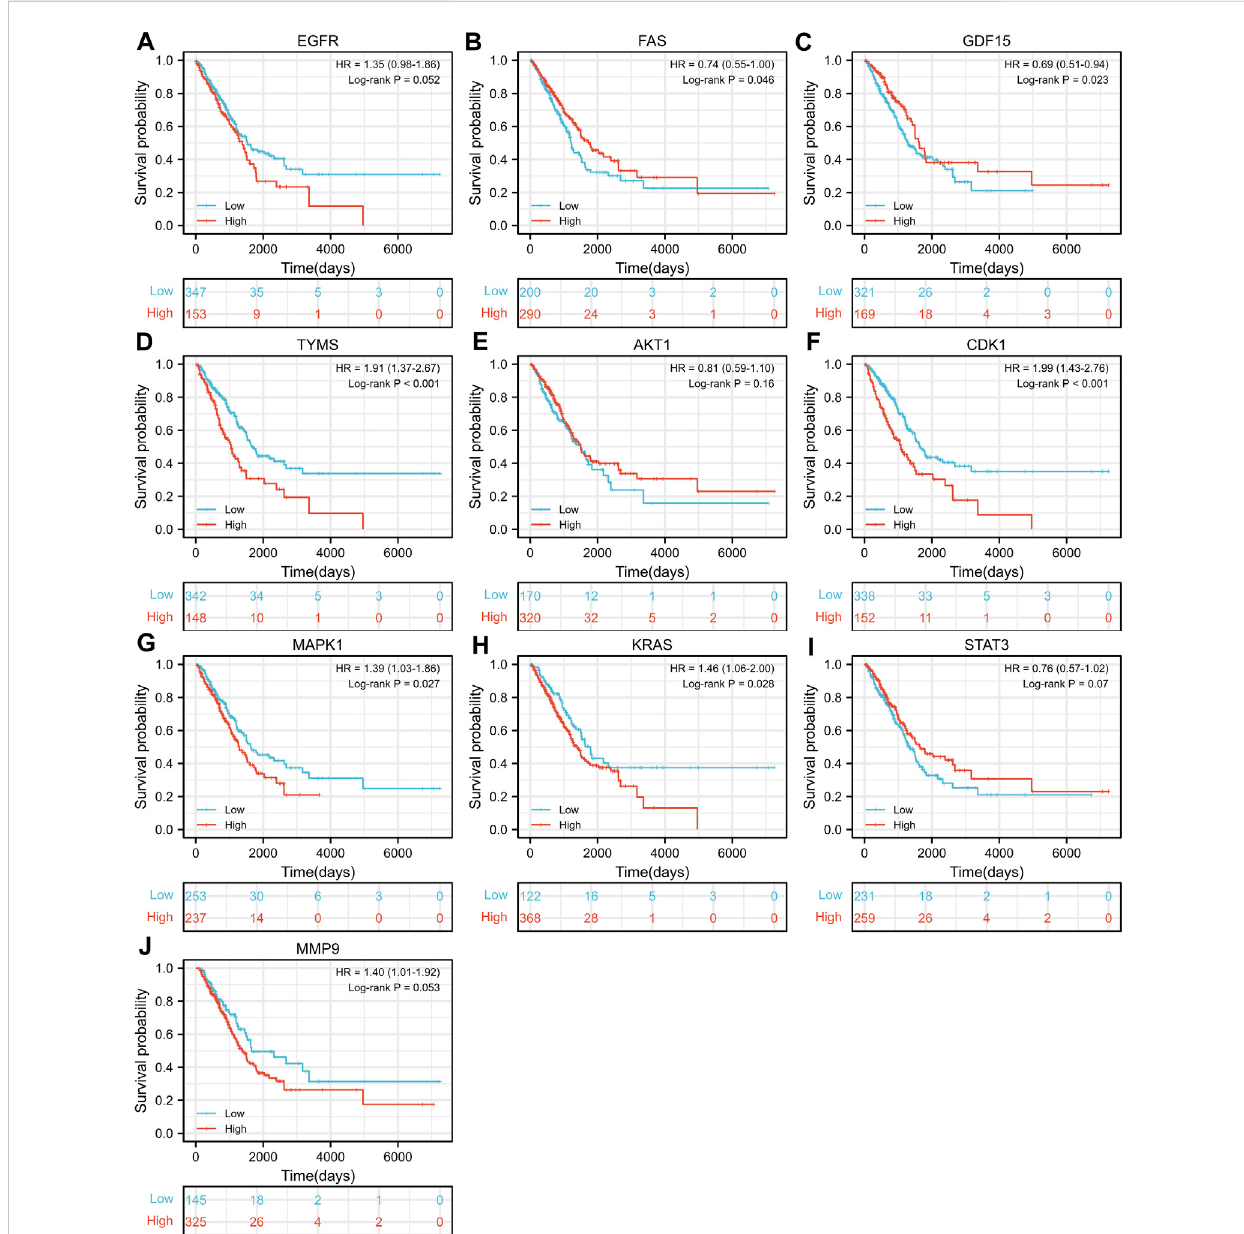
FIGURE 4 Kaplan-Meier Survival analysis of the correlation between expression of important target genes (A – J) and prognosis of LUAD in TCGA database.